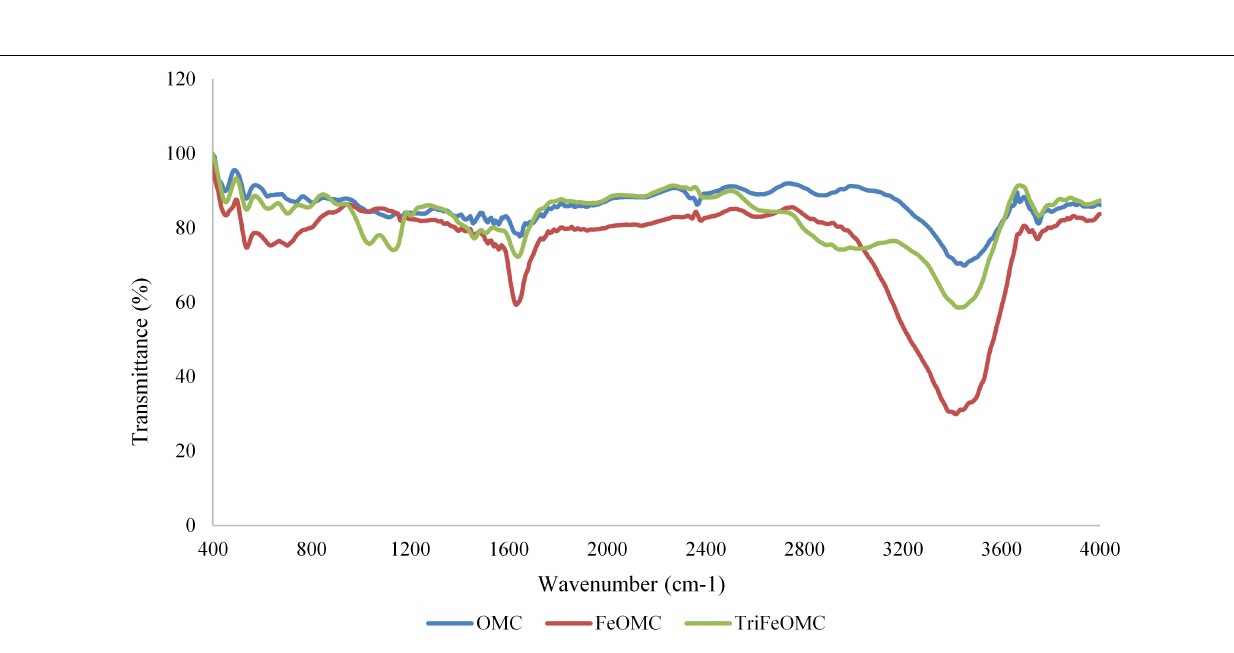
Frontiers in Materials |